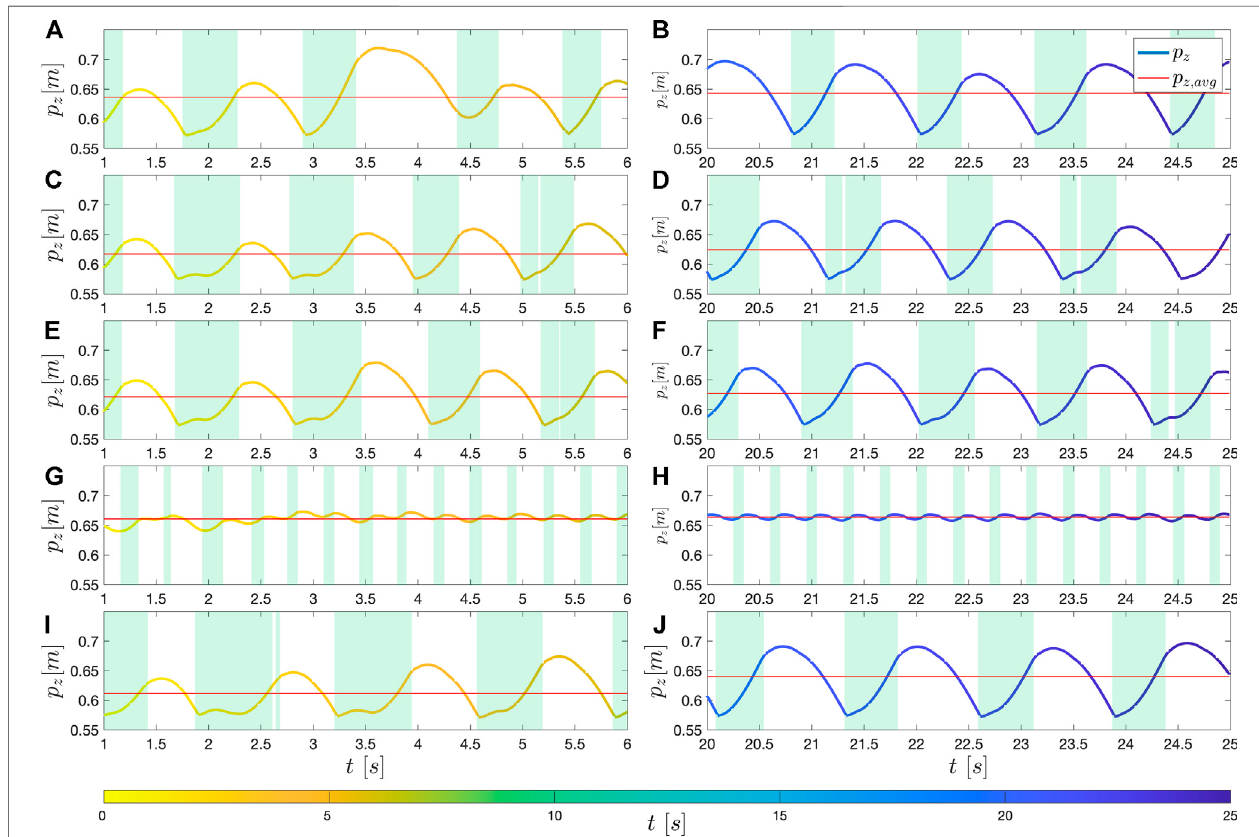
FIGURE 9 | The height of the pelvis, p z , over time when unseen modi fi cations are applied to the model in the nominal condition: (A,B) the nominal condition, (C,D) increased pelvis mass (+6.4%), (E,F) increased feet mass (+165%), (G,H) decreased command speed (0.1 m/s), and (I,J) : increased command speed (0.32 m/s). The red line is the average height in each time window. The left column is when in an earlier phase (1 s ≤ t ≤ 6 s), the right column is when in a latter phase (20 s ≤ t ≤ 25 s).